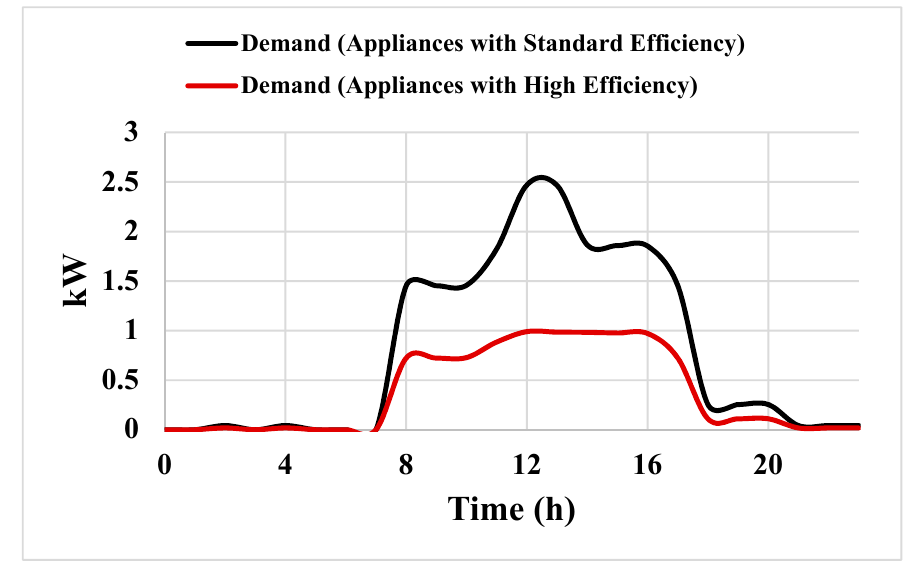
Figure 2. Daily Load Profile of the school with high and standard efficient appliances.